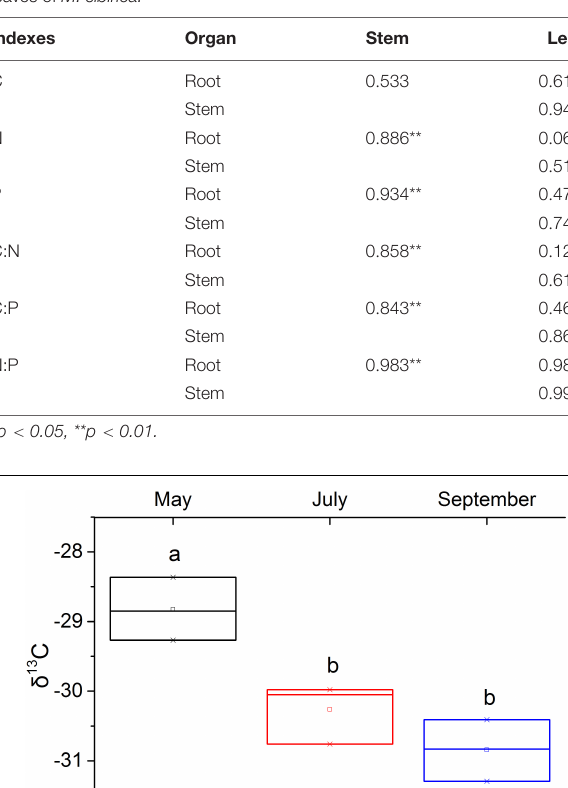
TABLE 2 | Correlation of C, N, and P stoichiometry among roots, stems and leaves of M. sibirica.